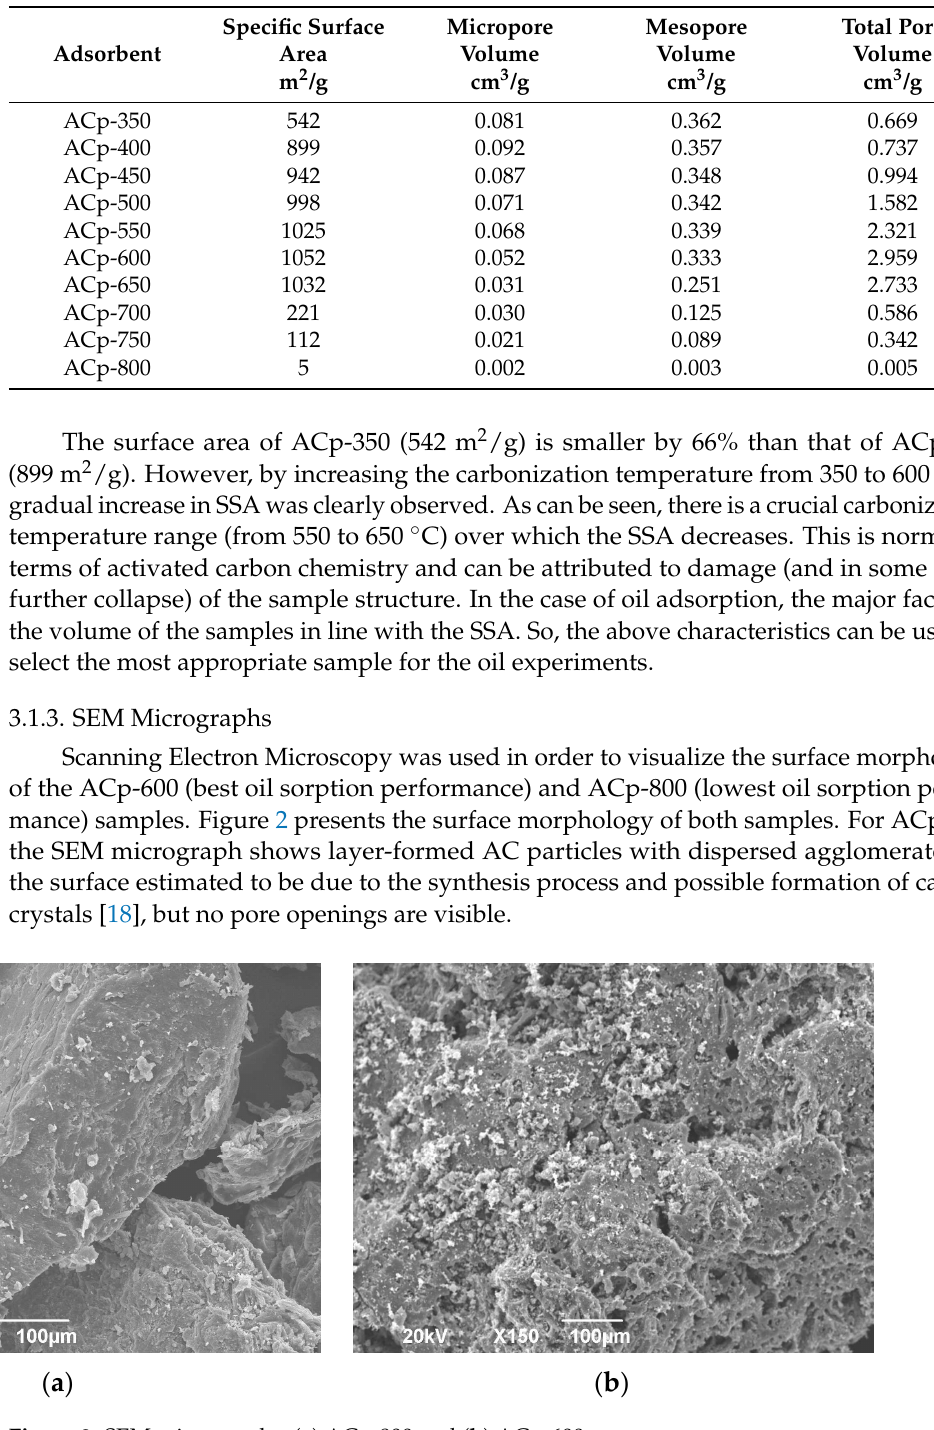
Table 1. Parameters of the pore structure calculated from nitrogen adsorption isotherms.